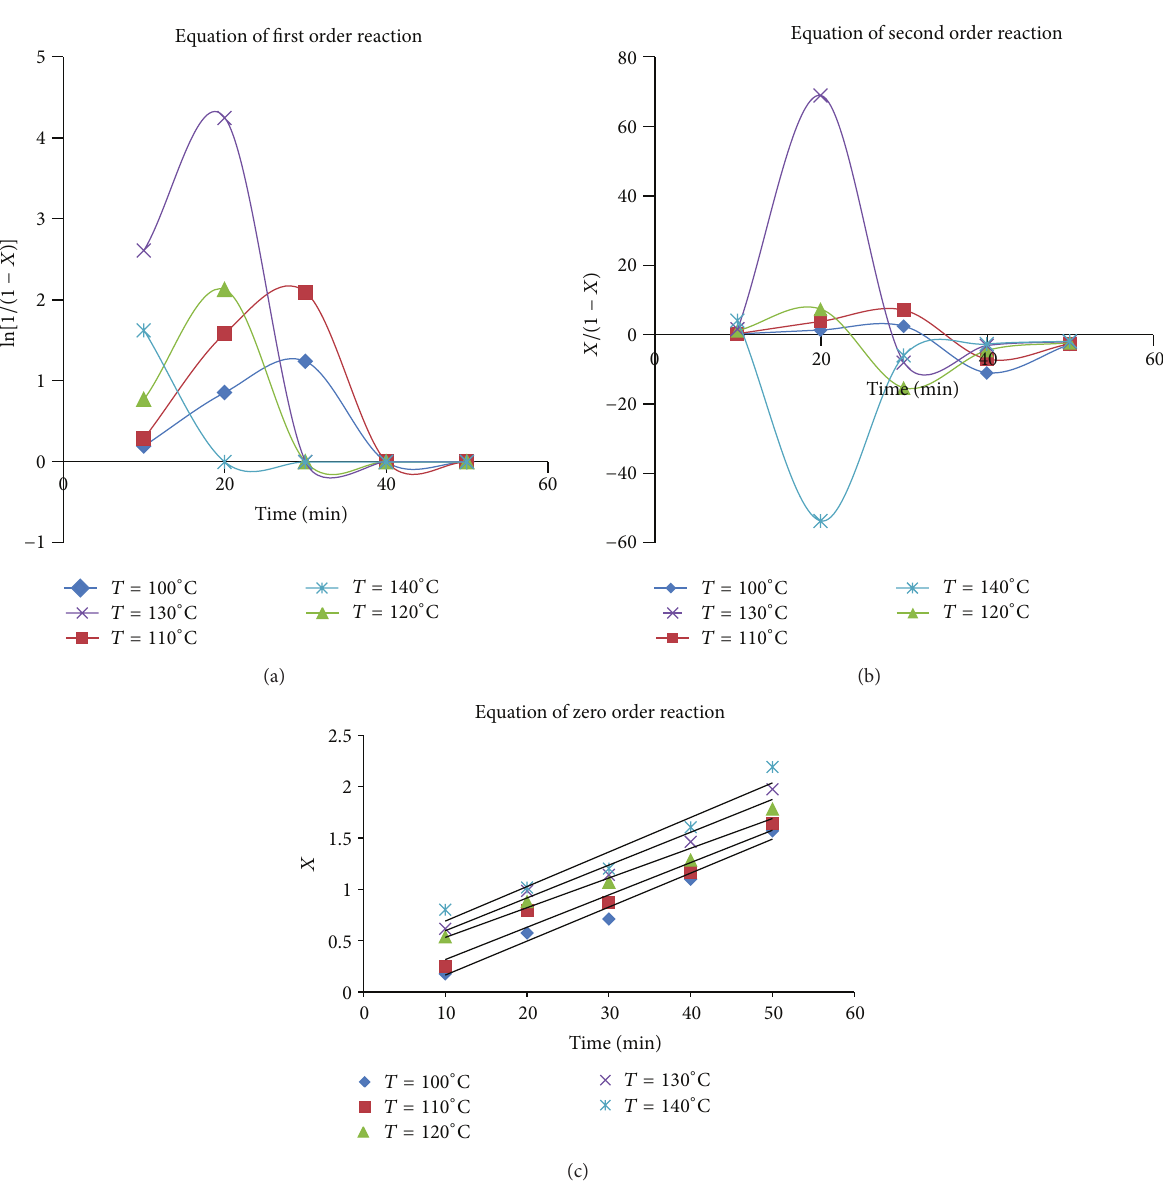
Figure 2: Plotting according to the equation of 1st, 2nd, and zero order reaction.